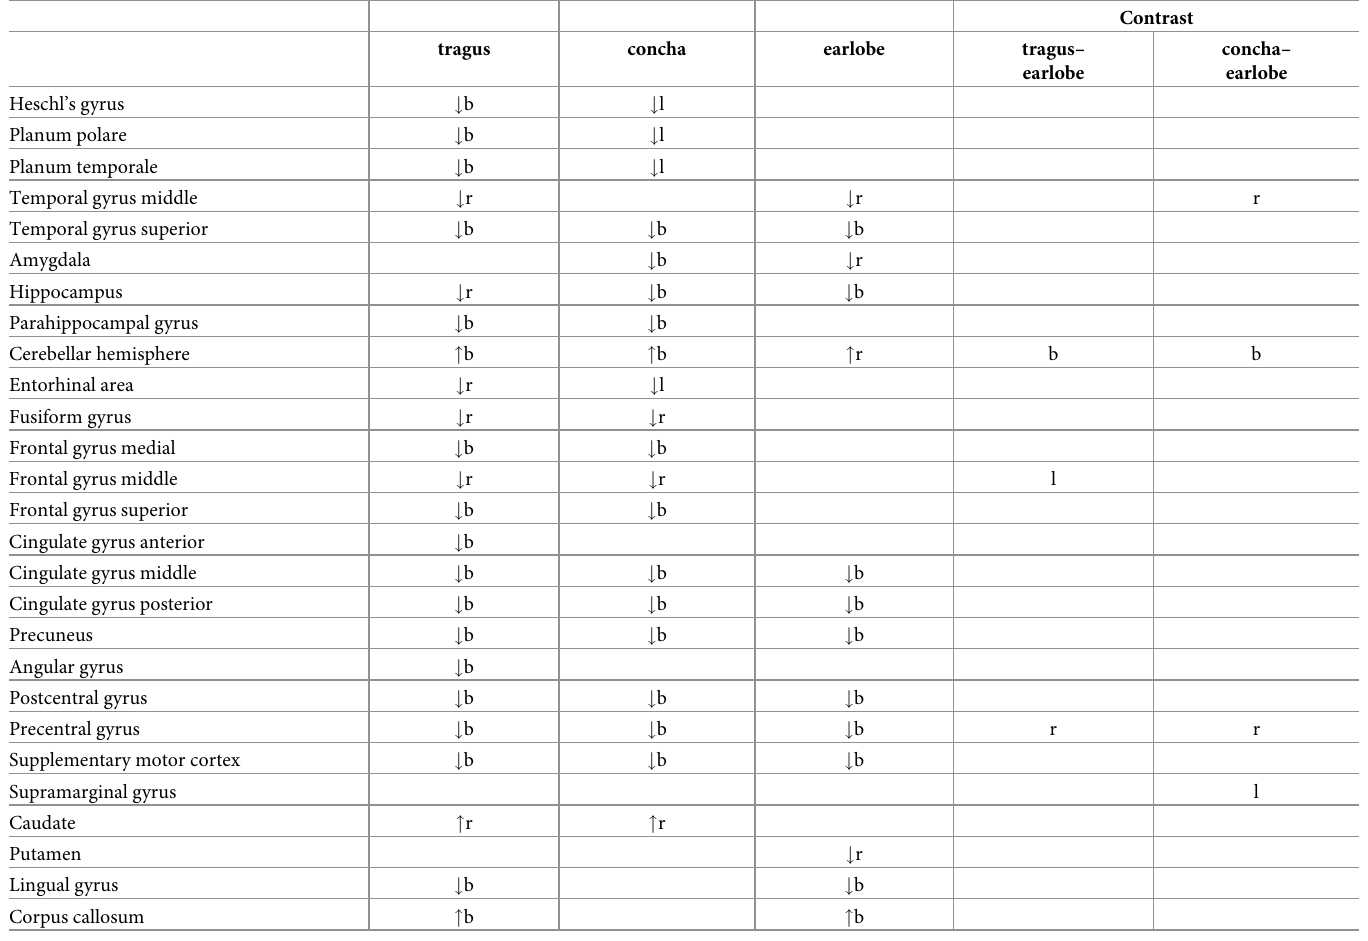
Table 3. Activated and deactivated regions revealed by general linear model